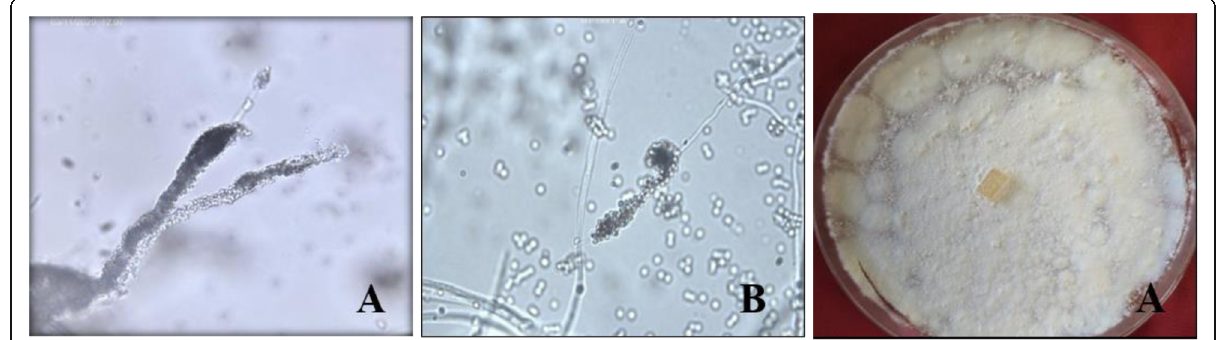
Fig. 1 Conidia of BGF14 ( a ) and BCA32 ( b ) isolates of Beauveria bassiana (×100 μ m) and fungal growth in PDA